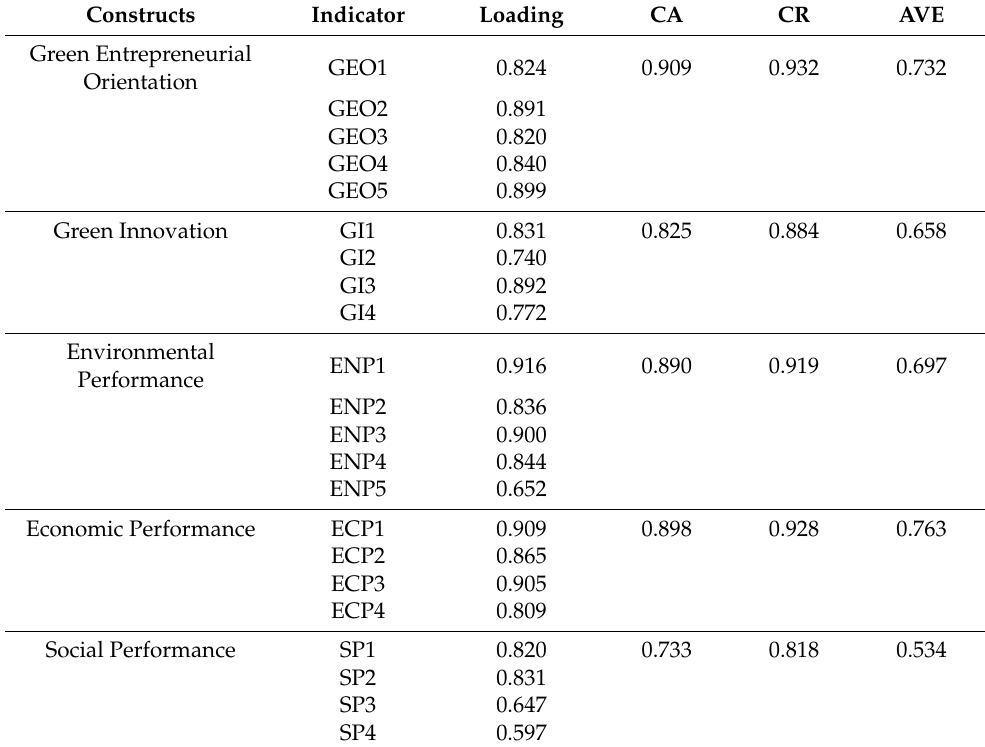
Table 2. Constructs’ reliability and convergent validity.